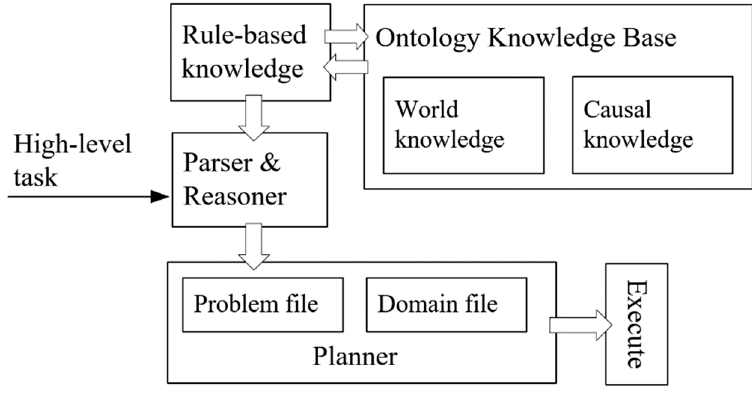
Figure 1. Knowledge representation in robot task planning.